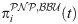
Spatially-explicit model: Each triplet of consecutive RUs can undergo 6 different transitions.For example, this figure shows the transitions of the configuration associated with the state variable πiPNP,BBU(t), with the corresponding transition rates. The transition rates computed thanks to Ass. (H1) are highlighted with a colored background.